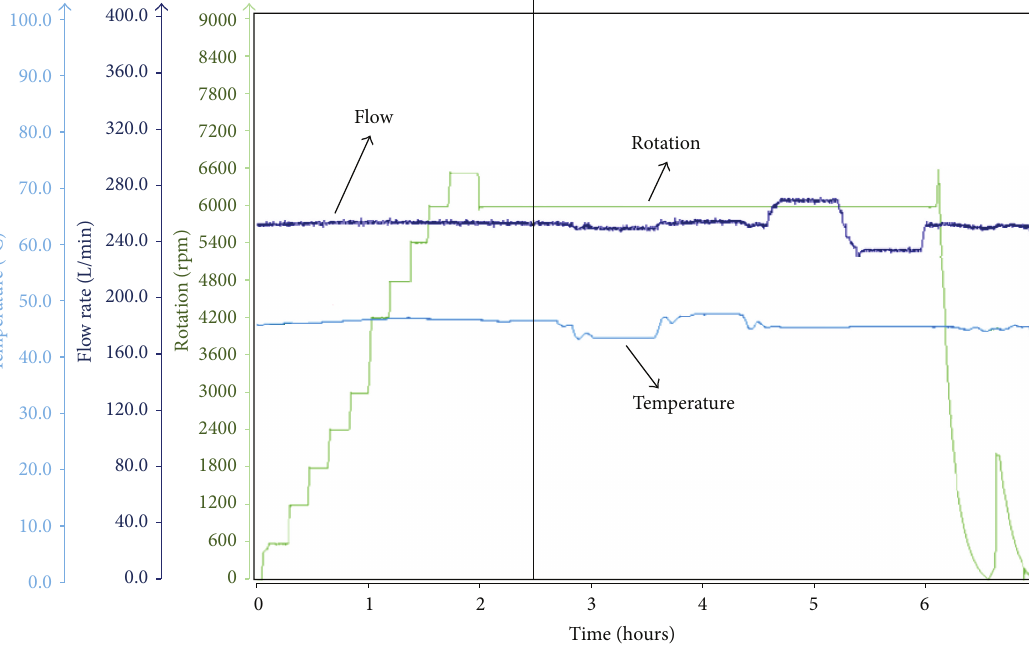
Figure 7: Experimental results: temperature of the oil supply; flow rate of the oil supply; rotational speed of the